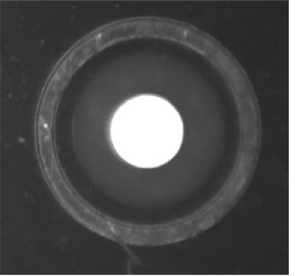
Figure 12. Since the image after point imaging will be an ellipse rather than an ideal circle, circle fitting is required.